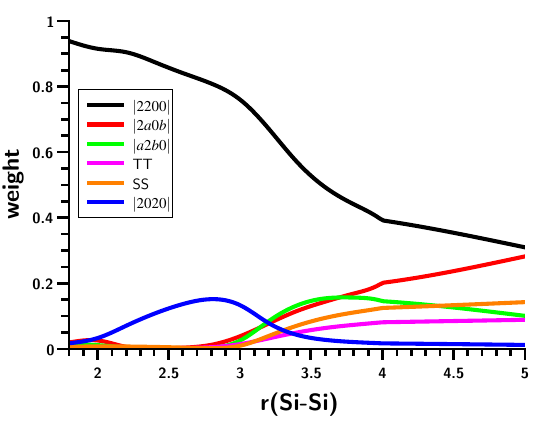
Figure 11. Non-planar silylene dimerization. Weights of the six most important MO-CSFs. Bond lengths in